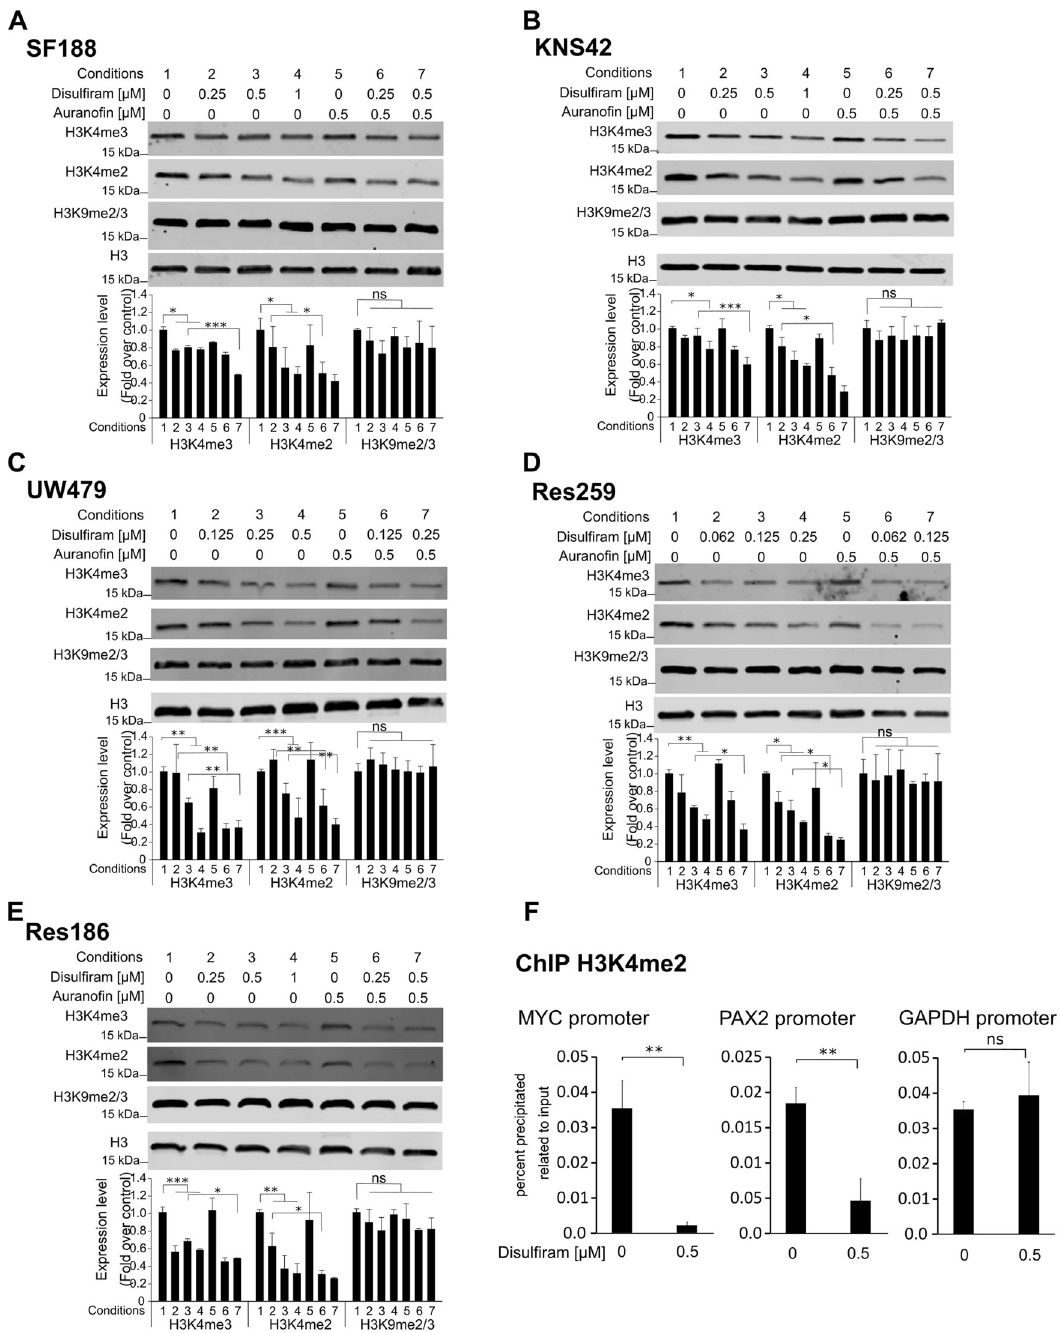
Fig. 4 Disul fi ram induces decrease of H3K4 methylation. A – E Top: whole-cell lysates were prepared from the indicated cell lines, cultured in the absence or presence of 0.5 mM aurano fi n with increasing concentrations of disul fi ram for 16 h. Extracts were probed with α -H3K4me2, α - H3K4me3, α -H3K9me2/3 antibodies, and α -H3 antibody as loading control. Bottom: the graphs represent image analysis of band intensity. Data are mean ± STD; n = 3; ∗ p < 0.05, ∗∗ p < 0.01 ∗∗∗ p < 0.001; two-way analysis of variance (ANOVA) test with Bonferroni posttest. F Chromatin immunoprecipitation analysis of H3K4me2 enrichment at promoter regions of MYC and PAX2. ChIP was performed using chromatin from SF188 left untreated or treated for 16 h with 0.5 µM disul fi ram. Data are mean ± STD; n = 3; ∗∗ p < 0.01, student t